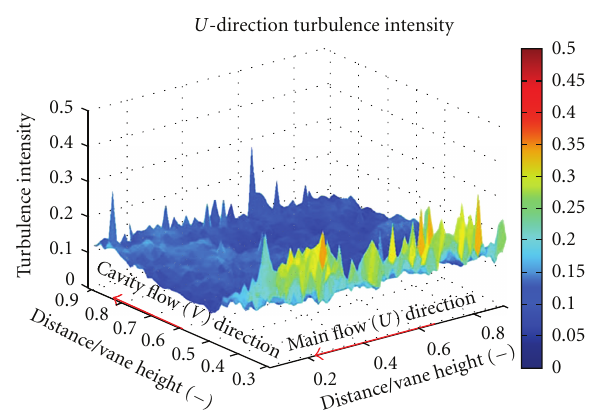
Figure 21: Streamwise turbulence intensity, equiv ratio = 1.0, straight cavity vane configuration, main and cavity airflows: 0.9 and 0.09kg/min.